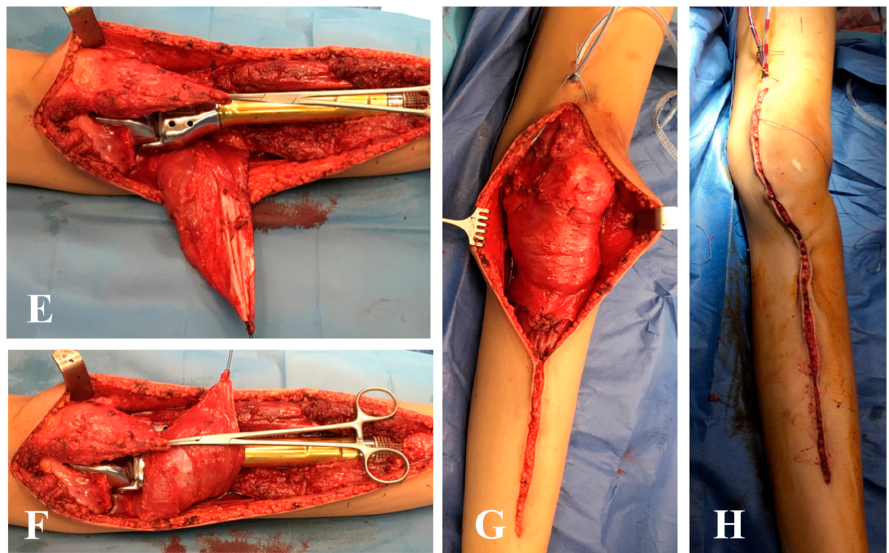
Figure 1. A 12-year-old male with osteosarcoma of the proximal tibia. ( A ) Swelling is visible in the soft tissue near the tibial tuberosity. ( B ) Surgical approach including the needle biopsy tract. ( C ) Surgical field after bone tumor resection and ( D ) after reconstruction with custom-made expandable prosthesis. ( E ) Distal detachment and rotation of the medial gastrocnemius muscle; ( F , G ) coverage of the prosthesis with the medial gastrocnemius and soleus muscle, and attachment of the extensor mechanism with sutures to the medial gastrocnemius. ( H ) Wound closure at the end of surgery. Regional flaps provide good solutions for not immediately adjacent small/moderate defects (Figure 2), whereas distal flaps could be used when the donor site is far from the defect, cutting and then re-attaching, micro-surgically, the blood supply at the recipient site (Figure 3).